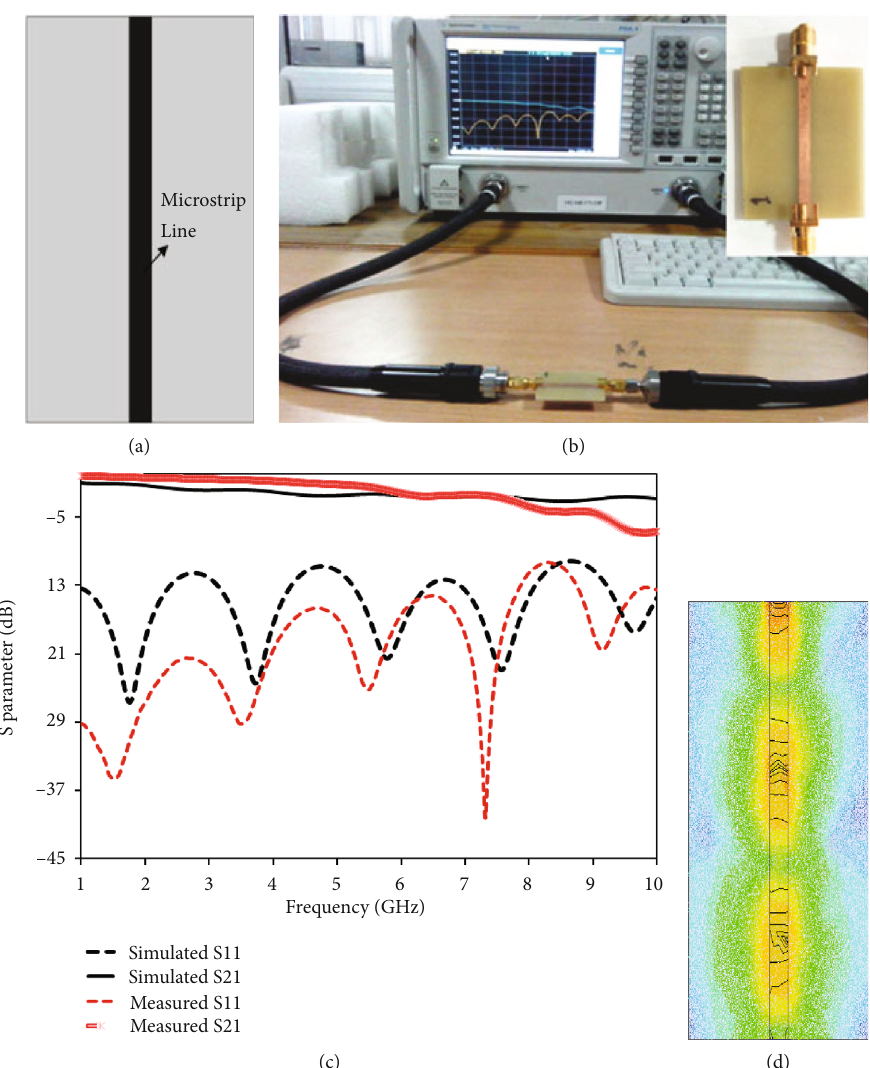
Figure 6: (a) Microstrip line; (b) measurement setup; (c) S parameter vs. frequency; (d) E fi eld